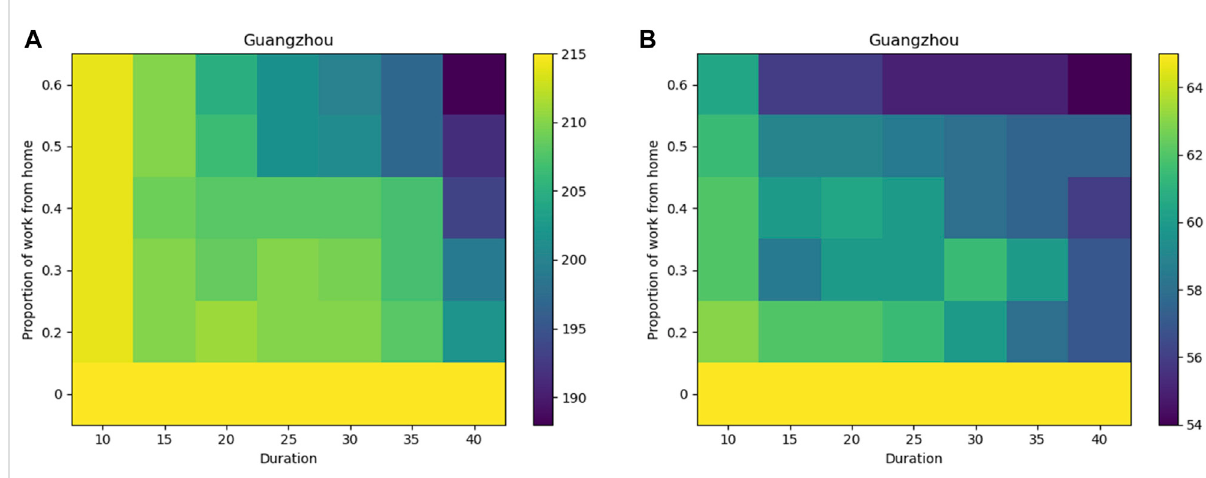
FIGURE 7 Effectofworkfromhomepolicies.HigherproportionorlongerdurationofcommutecontactrestrictiondenotesmoresevereNPIs.Wetakethe total number of infections (A) and the duration of the epidemic (B) as an evaluation index.